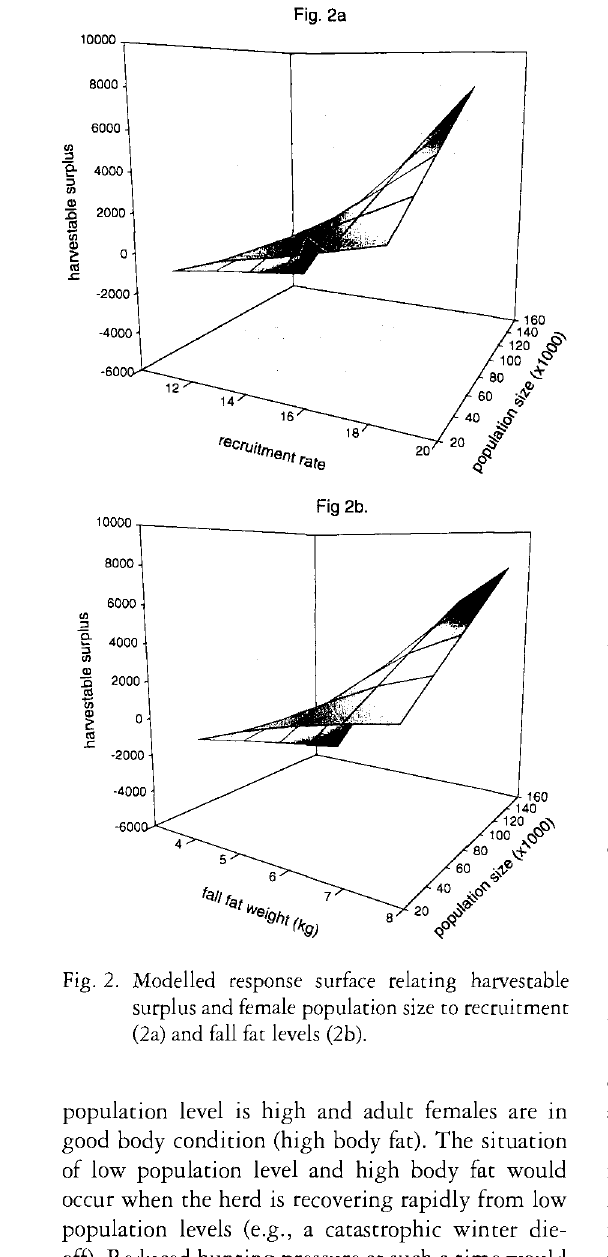
Fig. 2. Modelled response surface relating harvestable surplus and female population size to recruitment (2a) and fall fat levels